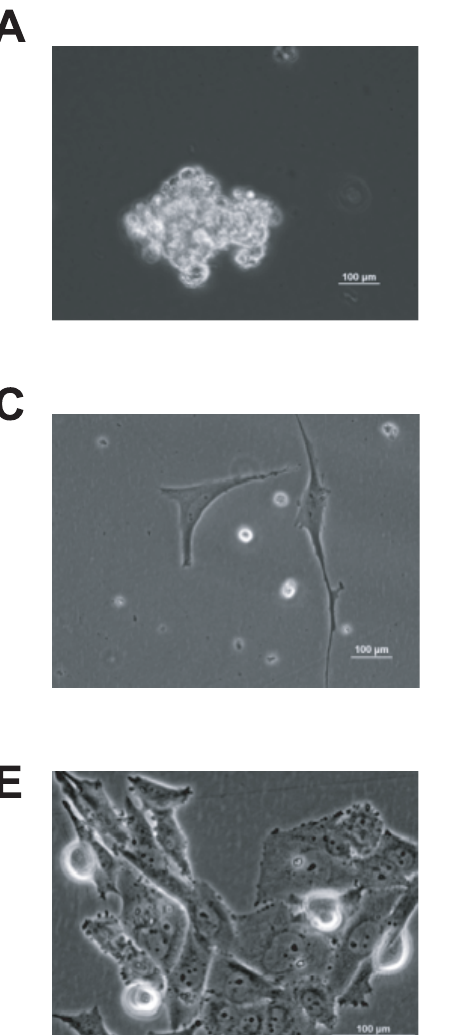
Figure 5. Phase contrast images of spheres formed by MACSorted CD133( + ) SAOS-2 osteosarcoma cells in ultra low-attaching dishes. A ) MACSorted CD133( + ) SAOS-2 cells assemble three-dimensionally as sarcosheres after 2 weeks of culture in ultra low-attaching dishes (20 6